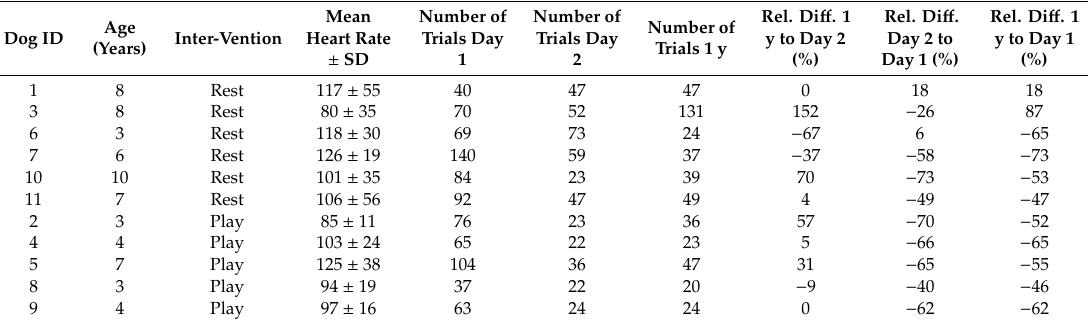
Table 2. Training performance data of retested individual